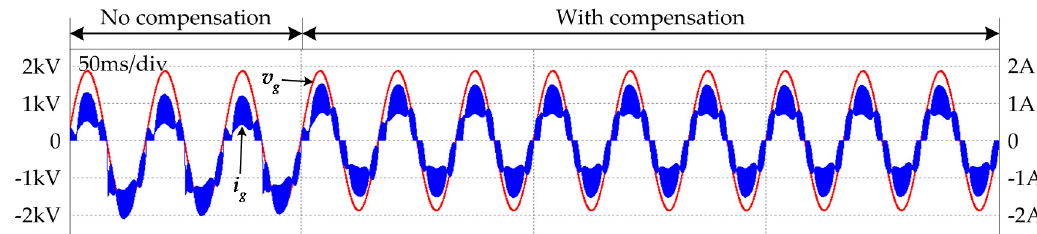
Figure 15. Simulated performance of the proposed offset compensation algorithm.